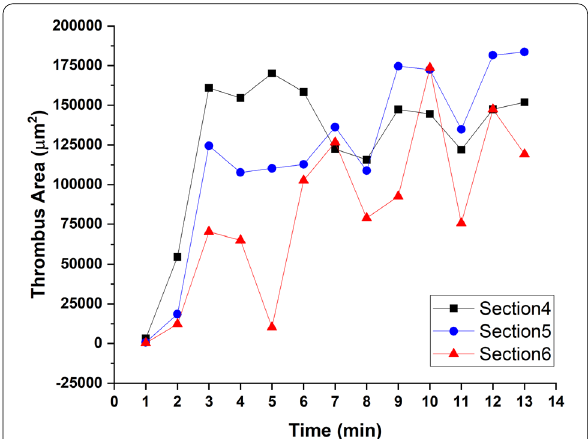
Fig. 8 Result of analyzing only the rear part of the stenosis section among the image analysis results by dividing the thrombus formed in the channel with 83.73% stenosis into six sections. Sudden drops of the thrombus area are caused by the embolus